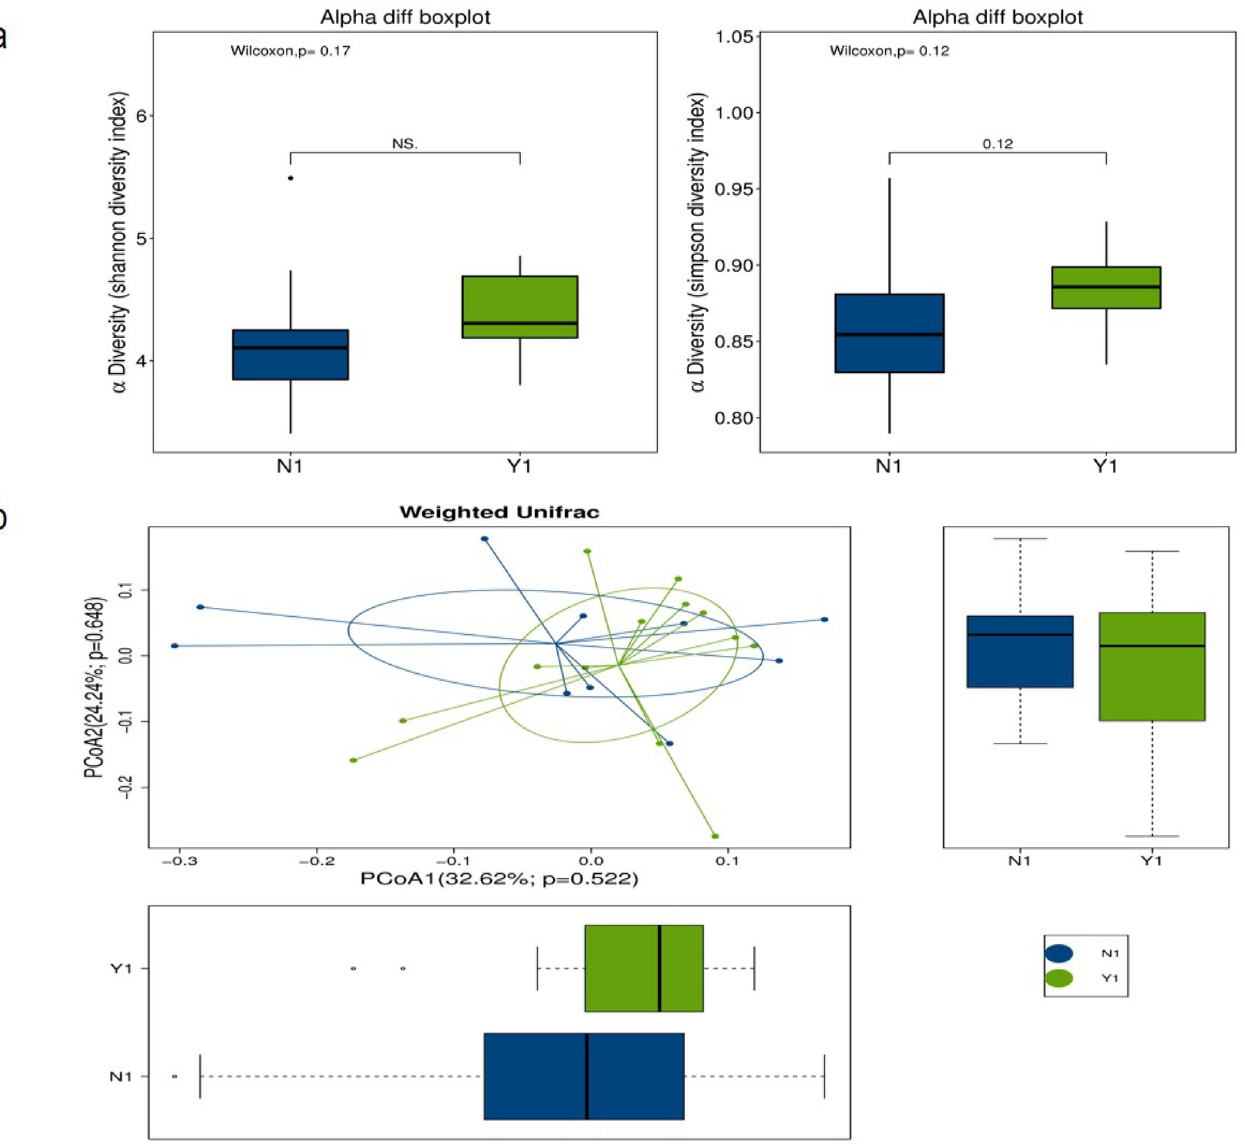
Fig 1. The alpha diversity and beta diversity for the effective group and ineffective group before the therapy. (a) Alpha diversity between the effective group and the ineffective group before the therapy; (b) Beta diversity between the effective group and the ineffective group before the therapy: Weighted Unifrac